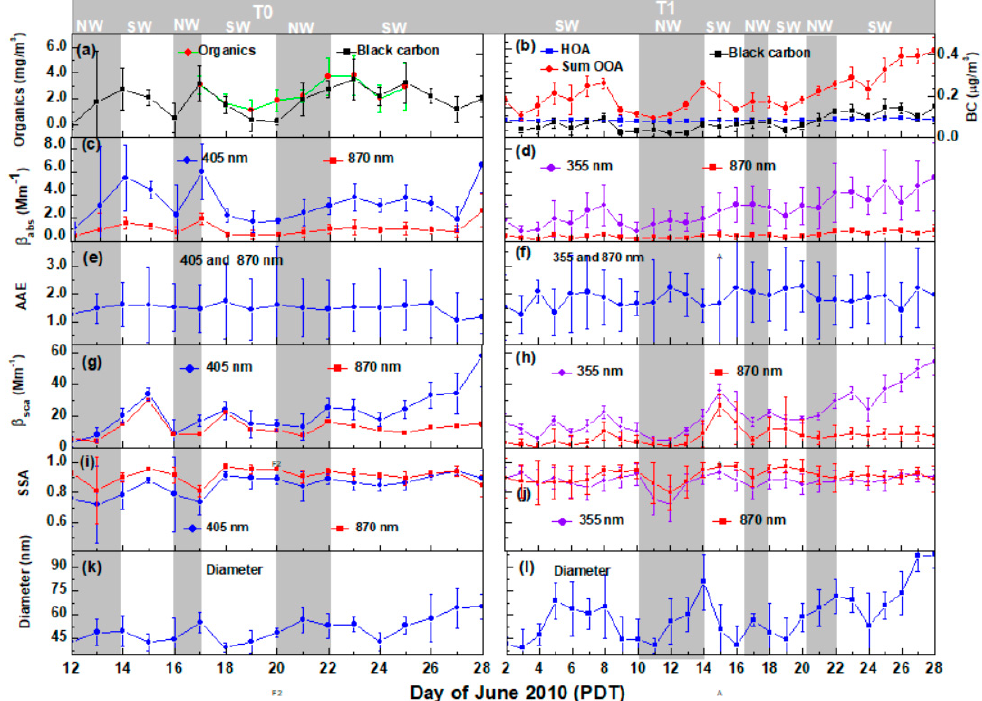
Figure 2. Daily daytime averages at T0, left panels, (12–28 June 2010) and T1, right panels, (from 2 to 28 June 2010) of: ( a , b ) PM 1 organic mass concentration and BC mass concentration; ( c , d ) aerosol absorption coefficients ( β abs ); ( e , f ) absorption Ångström exponent ( AAE ); ( g , h ) aerosol scattering coefficient ( β sca ); ( i , j ) single scattering albedo ( SSA ); and ( k , l ) PM 1 particle mean mobility diameter. Vertical bars (Figure 2 a – d , g , h , k , l ) represent one standard deviation (1 σ ) around the mean calculated for each vertical level. The error bars in AAE and SSA (Figure 2 e , f , i , j ) correspond to the total uncertainty, the square root of the sum of squares of the 1 σ around the mean, and the propagated error from the systematic errors (5% and 15% relative uncertainties in photoacoustic (PA) β abs measurements and reciprocal nephelometer (RN) β sca measurements, respectively). Each data point is averaged from 06:00 to 18:00 Pacific Daylight Time (PDT). The gray bar at the top indicates periods during which the synoptic wind was either southwesterly (SW) or northwesterly (NW). Semi-transparent gray shading for the NW flow periods is also shown over all the